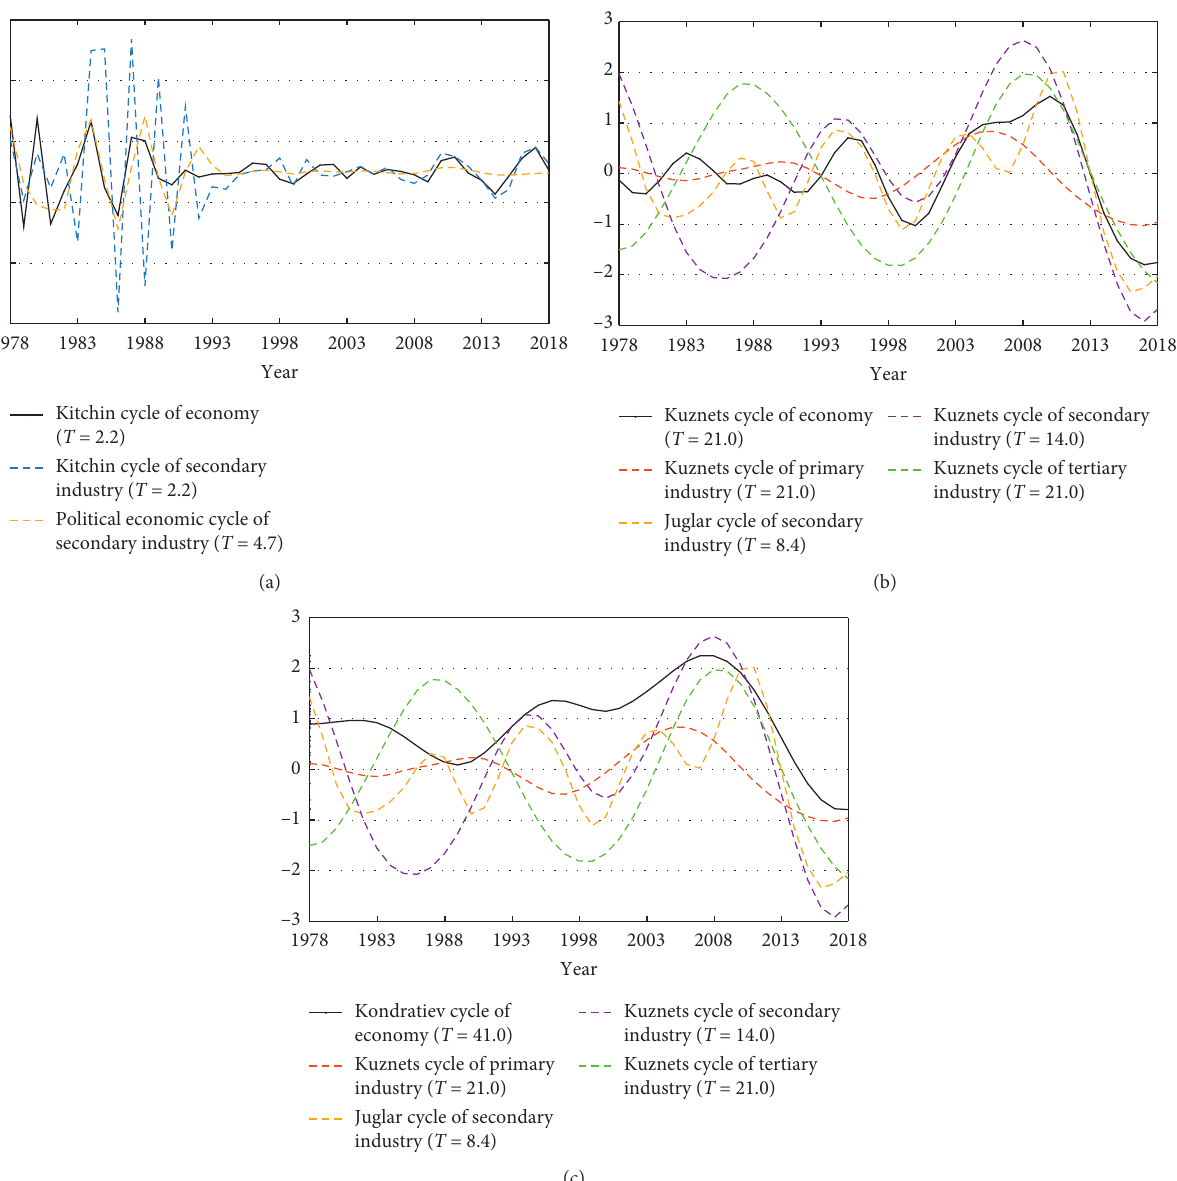
Figure 3: Line charts of the economic and industrial components in Heilongjiang Province. (a) Kitchin cycle of economy and related industry components. (b) Kuznets cycle of economy and related industry components. (c) Kondratiev cycle of economy and related industry